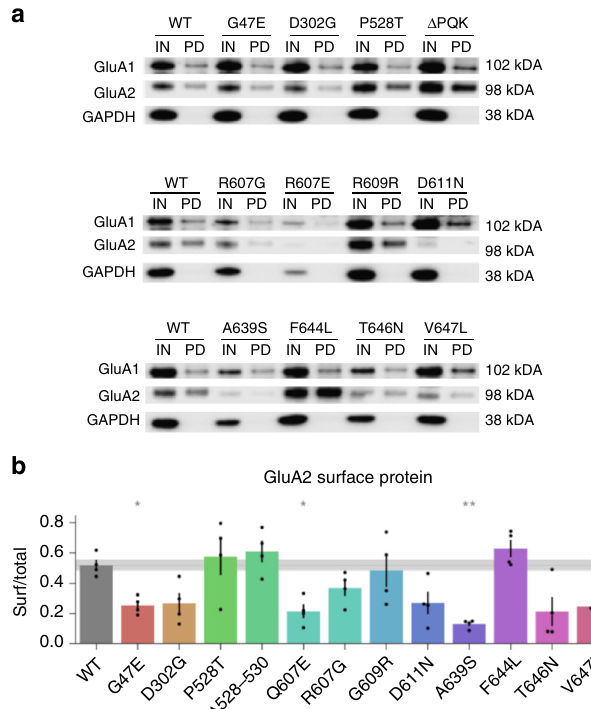
Fig. 9 Some GluA2 mutations disrupt surface expression. a Samples of transfected HEK cells biotinylated before (IN) and after puri fi cation by pull down with streptavidin beads (PD). b IN and PD were quanti fi ed relative to GADPH and then normalized to a WT control on the same gel. Surface protein was quanti fi ed as PD/IN. * p < 0.05, ** p < 0.01 vs WT. N = 4 experiments from independent batches of transfected cells phenotype. For another three mutations (p.G47E, p.Q607E, and p.A639S), GluA2 surface protein was signi fi cantly reduced in the